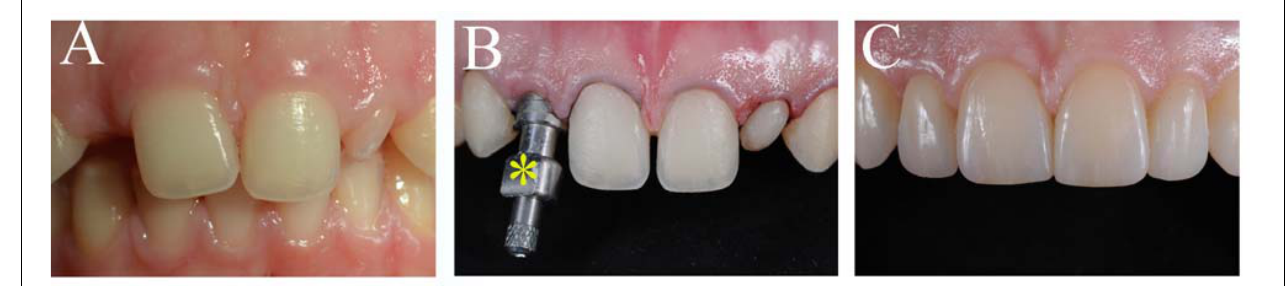
FIGURE 3 | Tooth replacement and correction of aesthetics in a patient. (A) Preoperative intraoral view of a young patient with a congenital missing tooth and compromised aesthetics of the other teeth. (B) Upon orthodontic, surgical and implant treatment, the teeth were prepared for aesthetic prosthetic rehabilitation. Asterisk indicates dental implant impression coping. (C) Postoperative intraoral view of the patient with the final ceramic